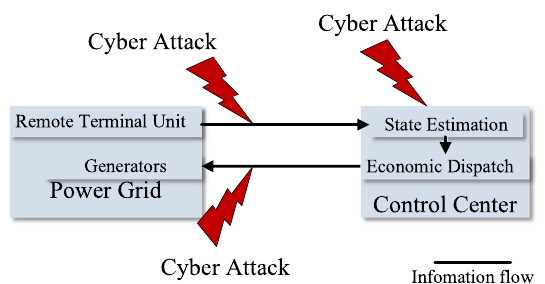
Fig. 1 Cyber-attacks on a power system